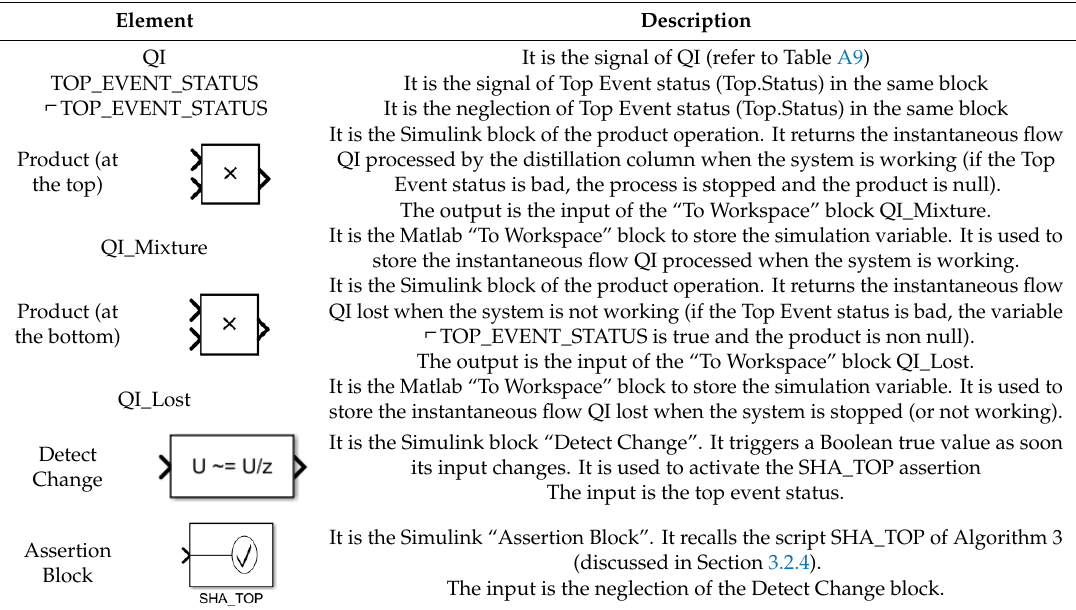
Figure A6. Block Parameters for the variables ( a ) QI and ( b ) %